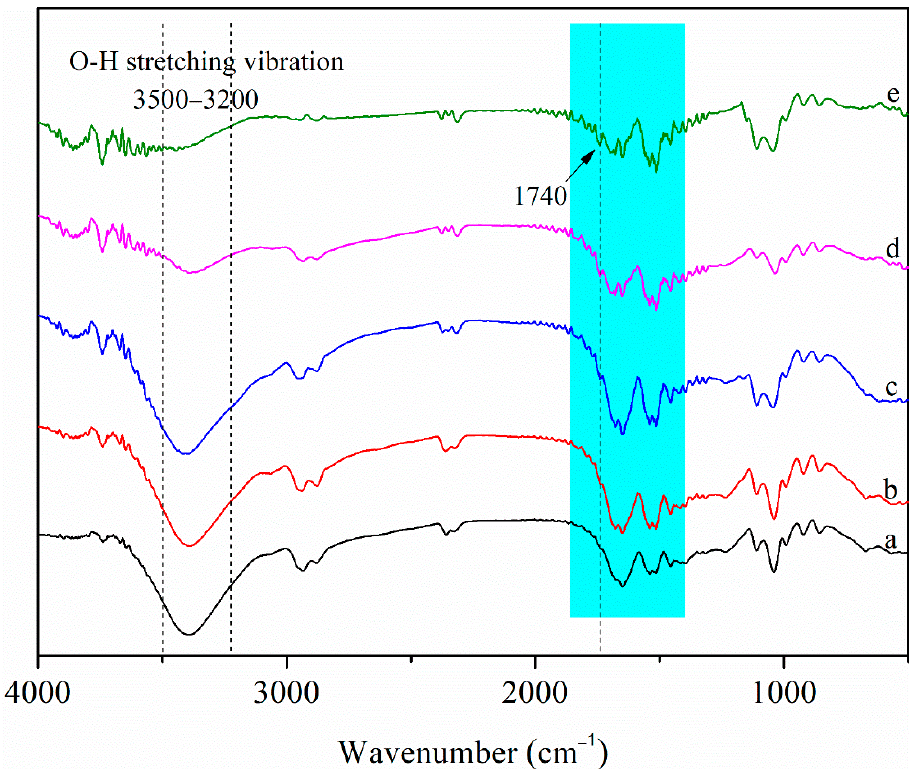
Figure 2. FT-IR spectra of Zein/NPs ( a ), Zein/NPs/2CNCs ( b ), Zein/NPs/4CNCs ( c ), Zein/NPs/6CNCs ( d ) and Zein/NPs/8CNCs ( e ).